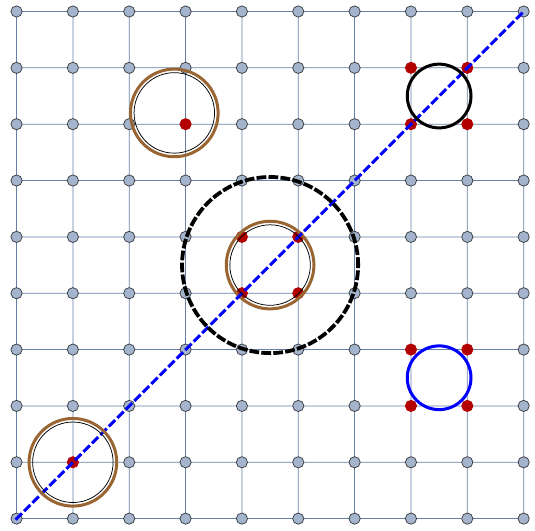
Figure 4 . Assuming twist gap g : operator spectrum of chiral Monster CFT tensored with its antichiral avatar on ( h 0 ; (cid:22) h 0 ) plane: each vertex in the lattice represents the presence of operators. One can always circumscribe a square of unit length by a circle of radius 1 p centered at ( h; (cid:22) h ) and of radius (cid:20) p + (cid:15) g with (cid:15) g > 0 ; (cid:20) (cid:21) 1 would contain at least an operator. This 2 is consistent with our result that asymptotically any square of side length 4 radius (cid:27)r p + (cid:15) g will contain at least one operator, where (cid:27) = max 2